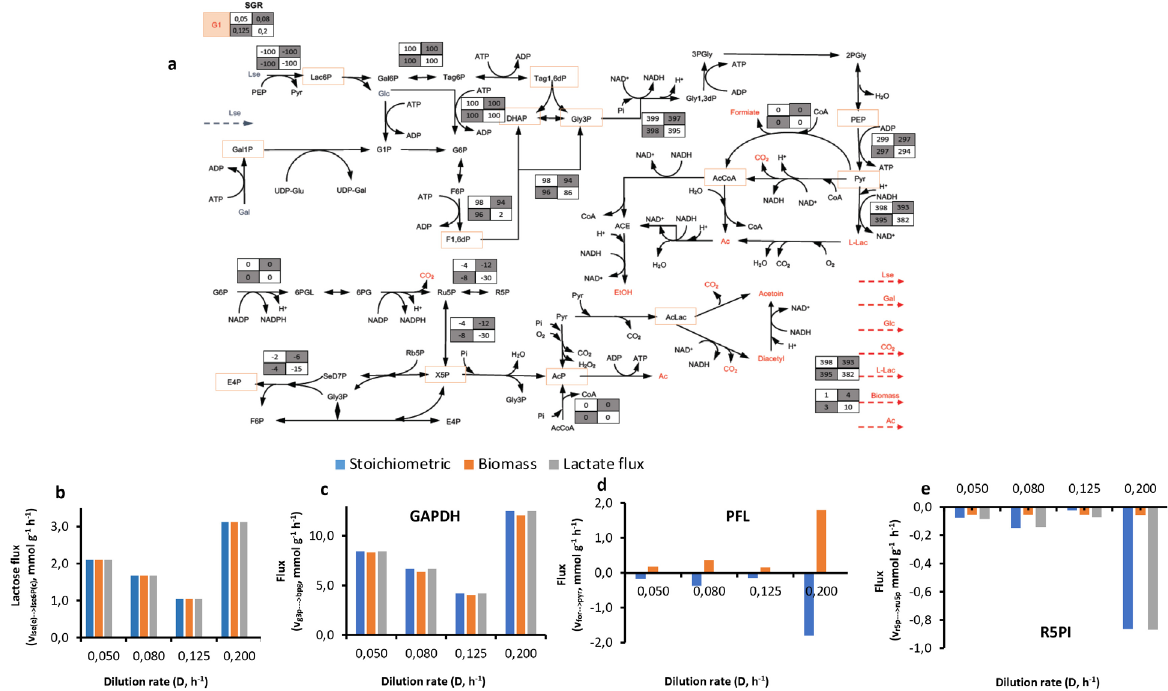
Figure 4. Metabolic map with restrictions caused by exchange reactions and intracellular metabolite concentration on th e i Lca334_548 model. a) % flux i = (reaction flux i / lactose flux) × 100. Bar graph for lactose, b) GAPDH: Glyceraldehyde 3-phosphate dehydrogenase, c) PFL: pyruvate formate lyase, d) R5PI: Ribose-5-phosphate isomerase and e) fluxes using stoichiometric values and those obtained when evaluating biomass function and lactate flux. SGR: specific growth rate; PEP: phosphoenol pyruvate; SerAL: L-serine ammonia-lyase;